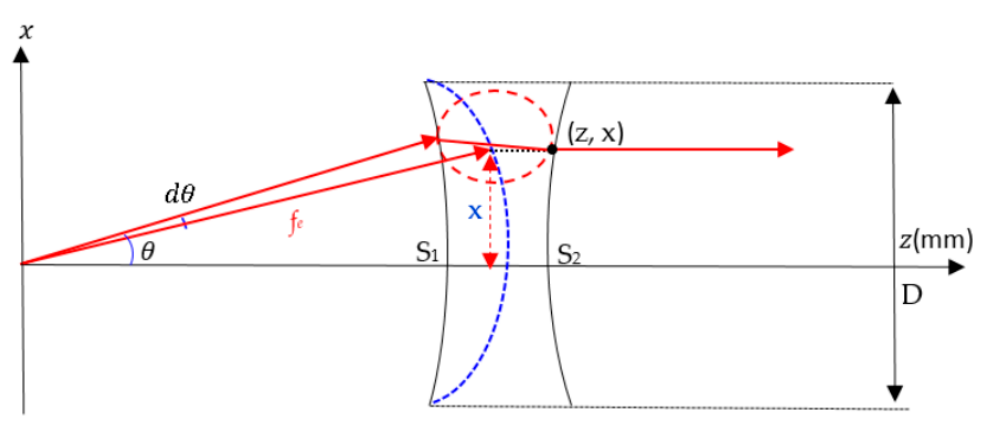
Figure 3. Abbe’s sine condition.